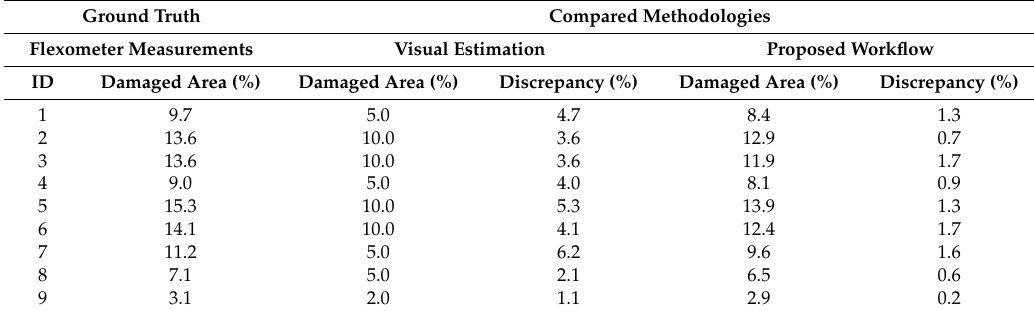
Table 6. Verification of the damaged area per PV panel regarding ground truth: IDs are defined in ascendant order from north to south and from west to